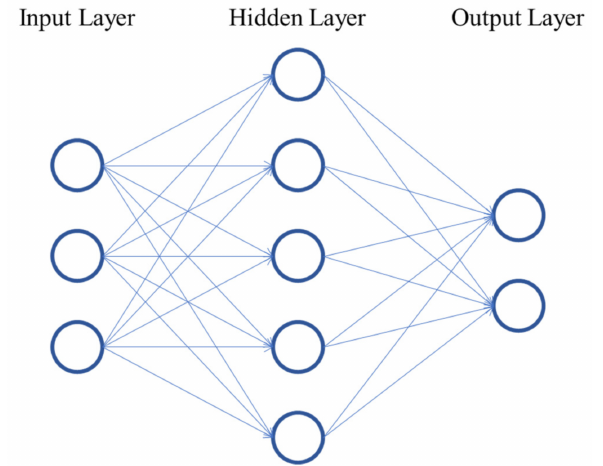
Figure 1. Neural network